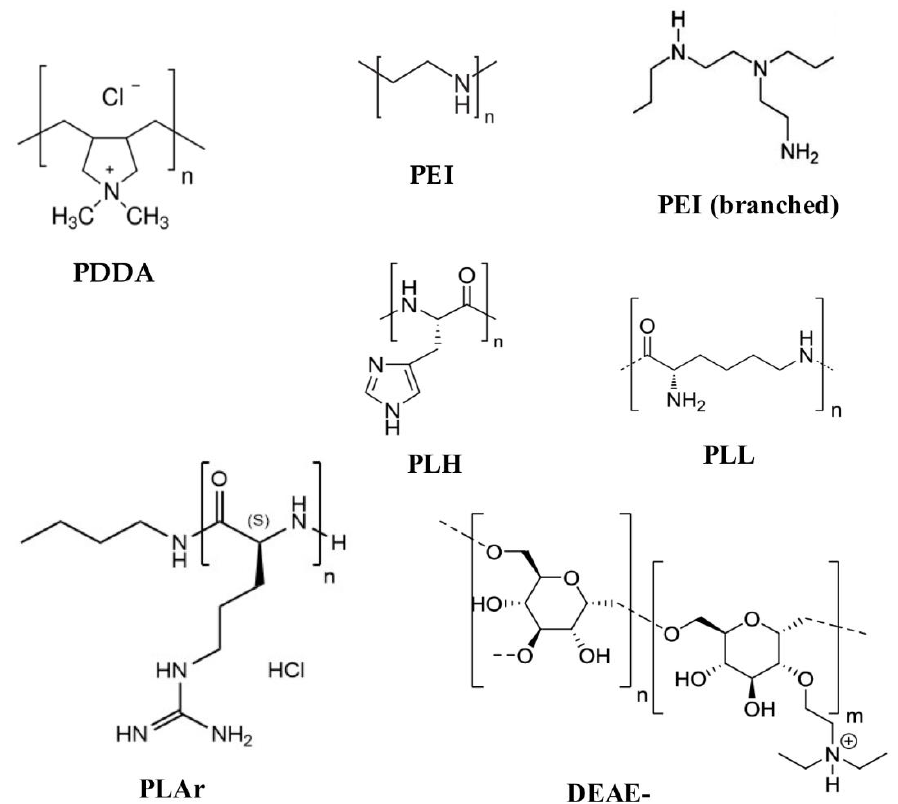
Figure 8. Chemical structures of some cationic polymers: poly (diallyldimethylammonium chloride) (PDDA), linear polyethyleneimine (PEI), branched polyethyleneimine (PEI), poly- L -arginine (PLAr), poly- L -lysine (PLL), poly- L -histidine (PLH), diethylaminoethyl-dextran (DEAE-).